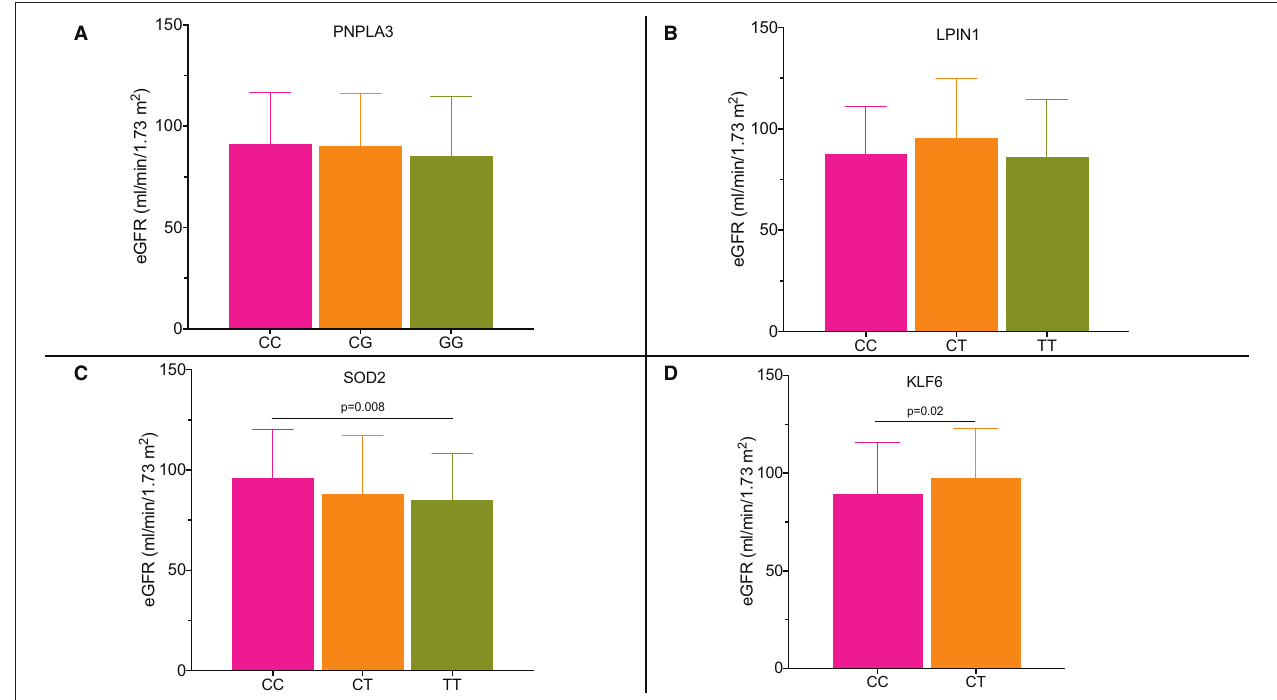
FIGURE 3 | (A–D) Estimated glomerular filtration rate (eGFR) according to the single nucleotide polymorphisms and their genotypes.